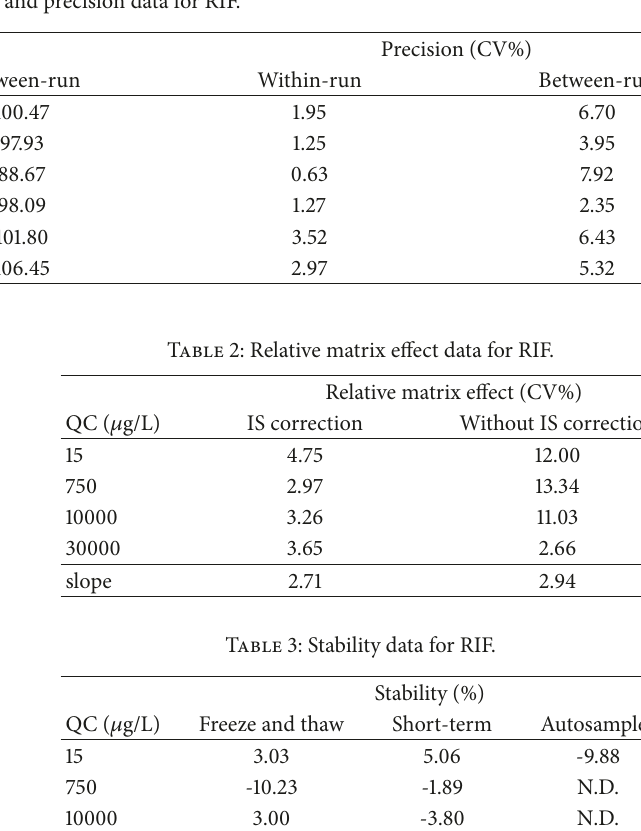
Table 1: Accuracy and precision data for RIF.